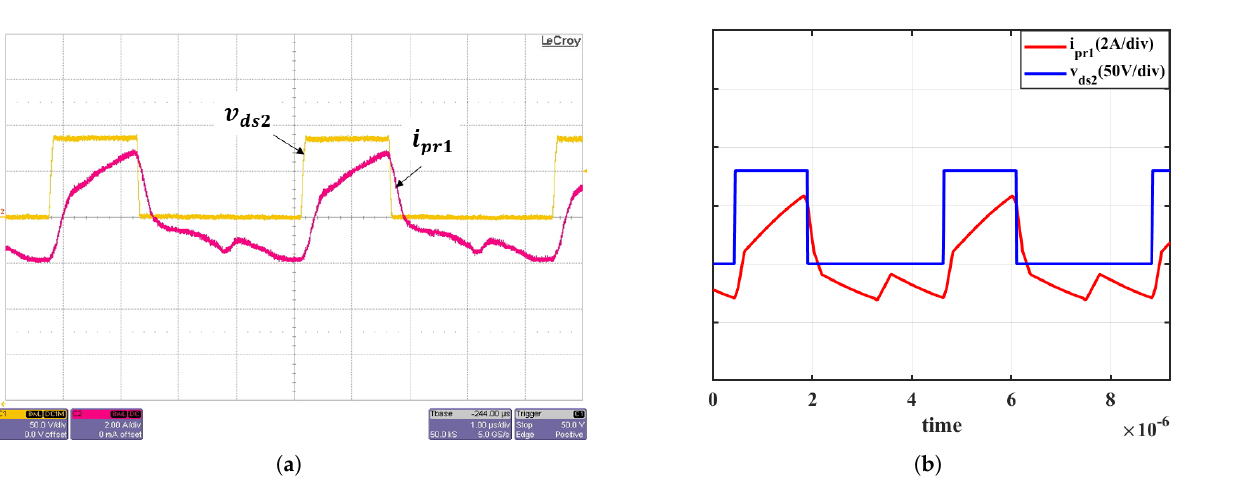
Figure 19. Waveforms at 80 V input and 10% load condition ( a ) Voltage across switch S 2 ( v ds 2 (50 V/div)) and primary current i pr 1 (2 A/div) ( b ) Simulated voltage ( v ds 2 (50 V/div)) and current i pr 1 (5 A/div) from